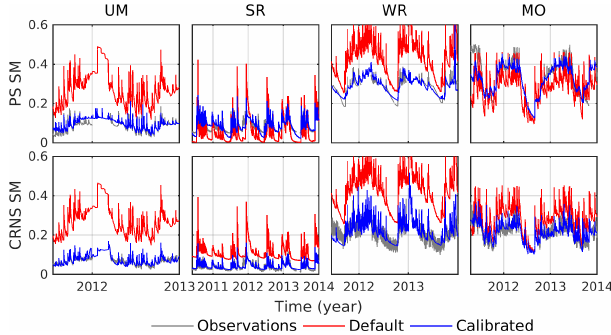
Figure 5. Hourly soil moisture time series of JULES default and calibrated runs against observations (PS or CRNS) for 4 of the 12 sites.